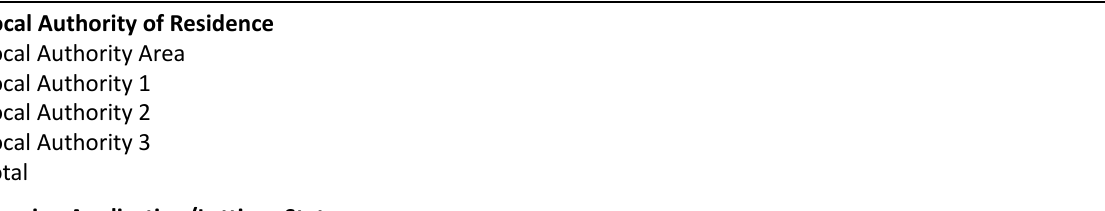
Table 1. Characteristics of participants at first interview (N = 28 households with at least one disabled person).